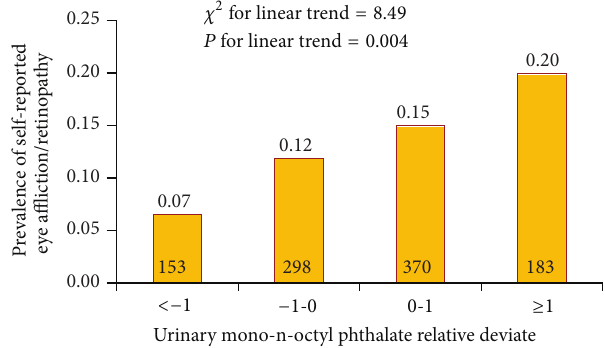
Figure 3: Dose-response relationship of urinary mono-n-octyl phthalate with self-reported eye affliction/retinopathy in NHANES 2001–2010 participants. Bars represent the survey-design-corrected prevalence within categories of subjects defined by the relative deviate (mean/standard deviation) of inverse-normalized, dilution corrected urinary MOP concentration. Linear trend was assessed using the Armitage test for linear